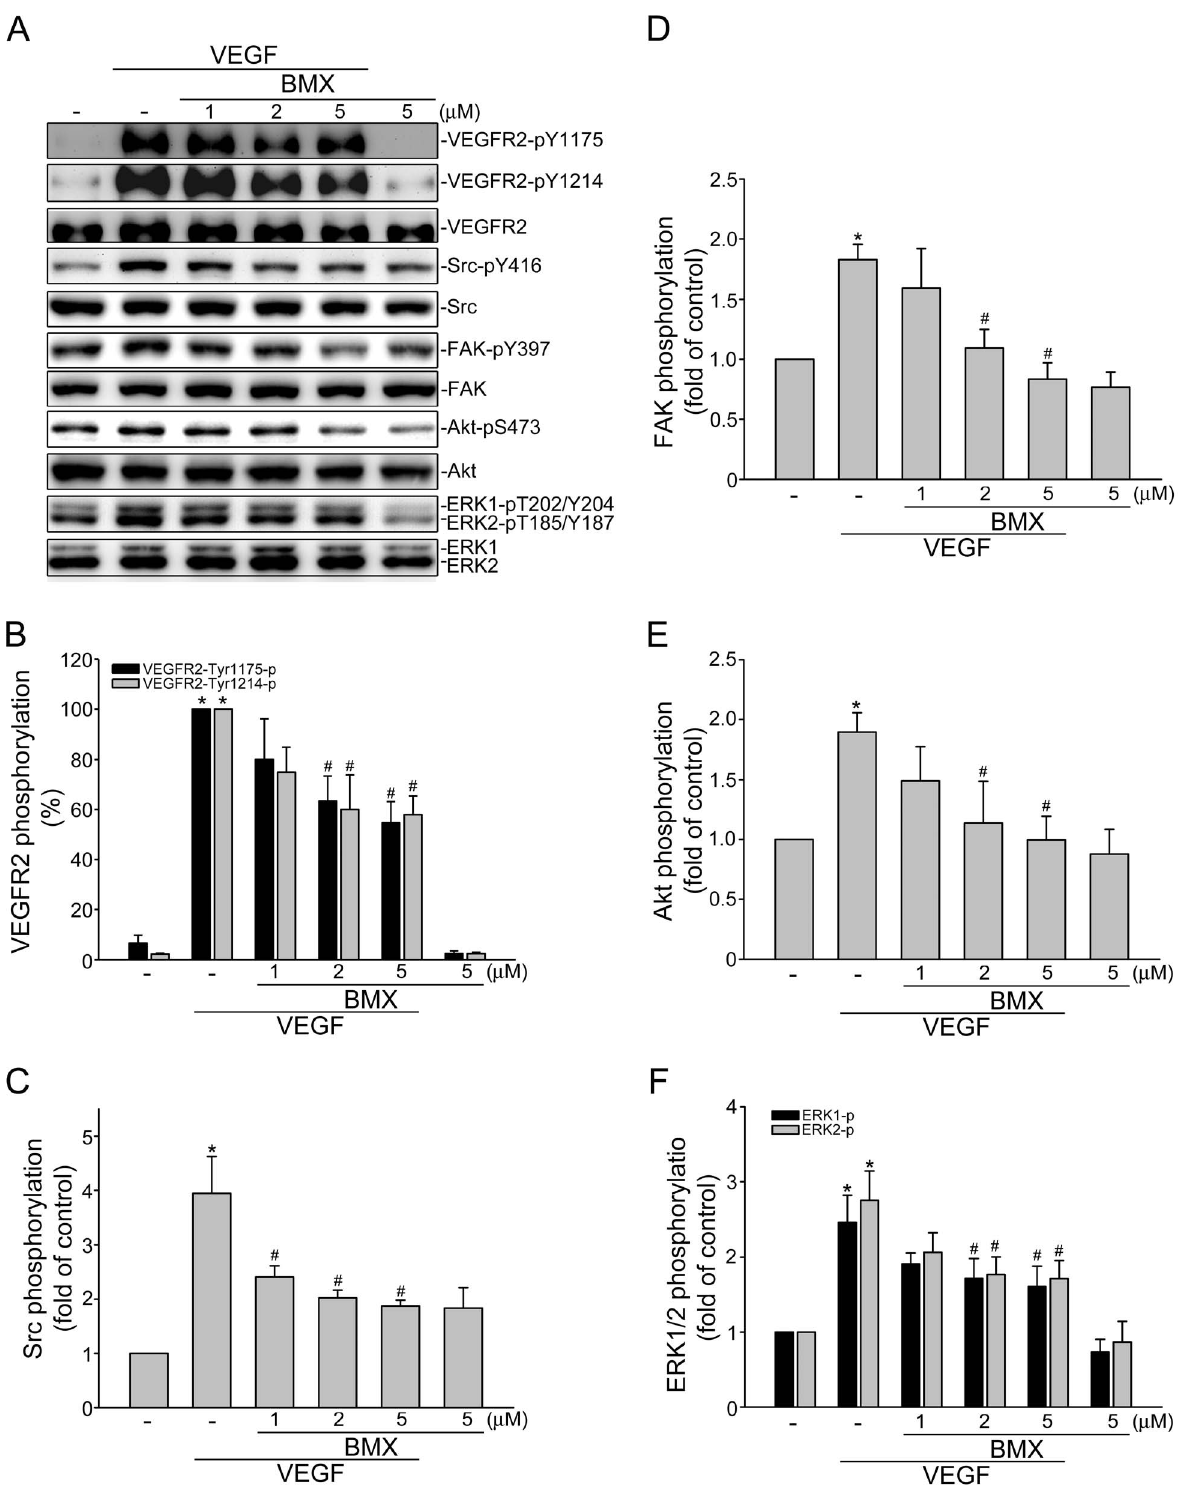
Figure 4. BMX inhibited VEGFR2 signaling pathways in HUVECs. Cells were pretreated with indicated concentrations of BMX for 30 min, followed by the addition with VEGF (20 ng/ml) for another 5 (VEGFR2 and Src) or 30 (FAK, Akt and ERK1/2) min. Phosphorylation status of VEGFR2, Src, FAK, Akt, and ERK1/2 were then determined by immunoblotting. Figures shown in (A) are representative of four independent experiments with similar results. The compiled results of VEGFR2 Y1175 and Y1214 (B), Src Y416 (C), FAK Y397 (D), Akt S473 (E), and ERK1/2 T202/Y204 (F) phosphorylations are shown. Each column represents the mean 6 S.E.M. of four independent experiments. * p , 0.05, compared with the control group; # p , 0.05, compared with the group treated with VEGF alone.